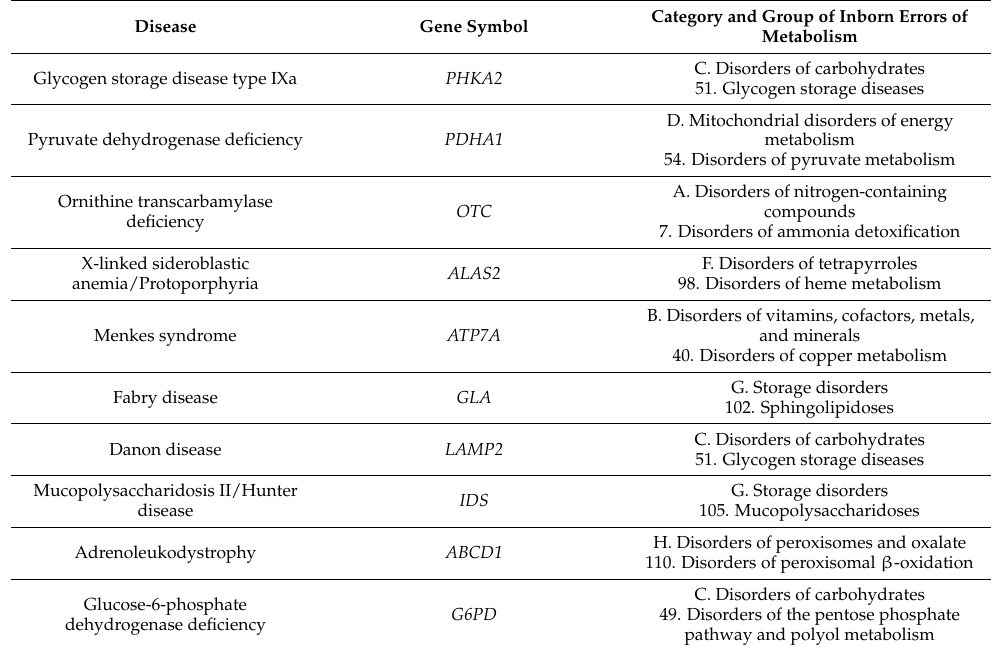
Table 3. Nosology of the disorders described in this review according to Ferreira et al.